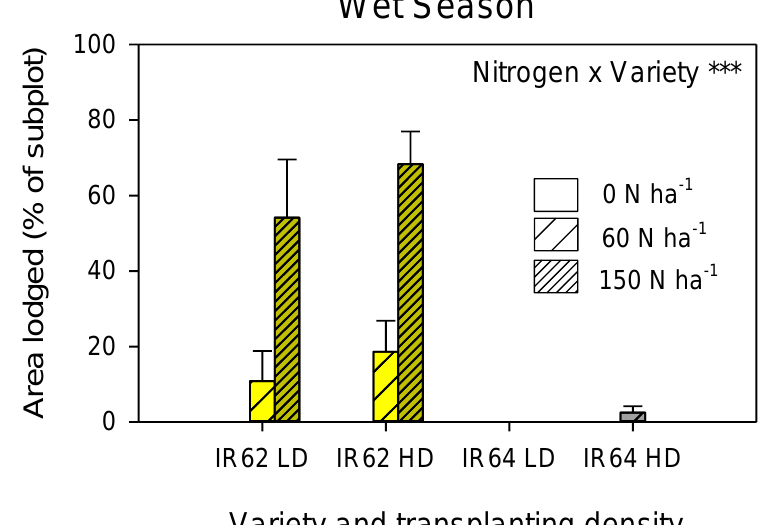
Figure 8. The percentage area of subplots with lodged rice plants following a tropical storm. Subplots were transplanted with resistant (IR62: yellow bars) and susceptible (IR64: grey bars) rice at low (LD) and high (HD) densities under varying nitrogen fertilizer treatments. Nitrogen was applied at 0 Kg ha − 1 (open bars), 60 Kg ha − 1 (hatched bars) and 150 Kg ha − 1 (densely-hatched bars). The factors that significantly affected lodging are presented with significance levels as *** = p ≤ 0.005. Lodging was noted only during the wet season. Standard errors are indicated ( N = 6).